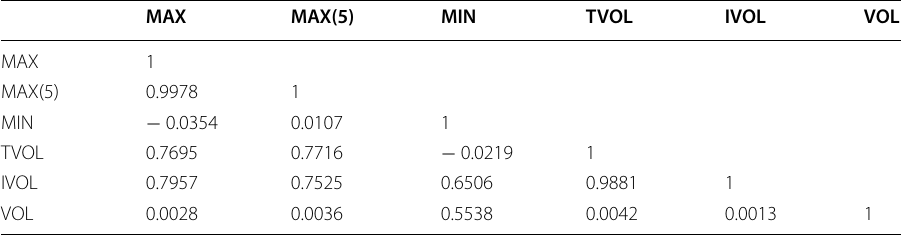
Table reports the averages of the weekly cross‑sectional correlations of the maximum daily return in a month (MAX), the average of the highest five daily returns in a month (MAX(5)), the minimum daily return in a month (MIN), total volatility (TVOL), idiosyncratic volatility (IVOL), and Garman‑Klass volatility